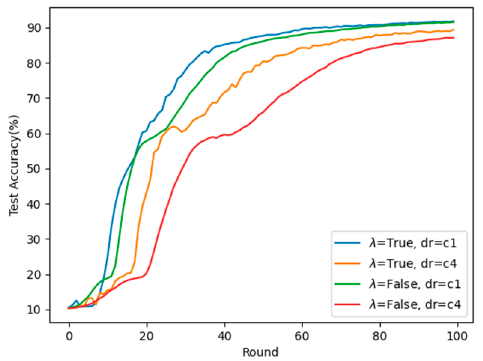
Figure 6. Accuracy by cluster-based dropout and training weights ( 𝜆 ).